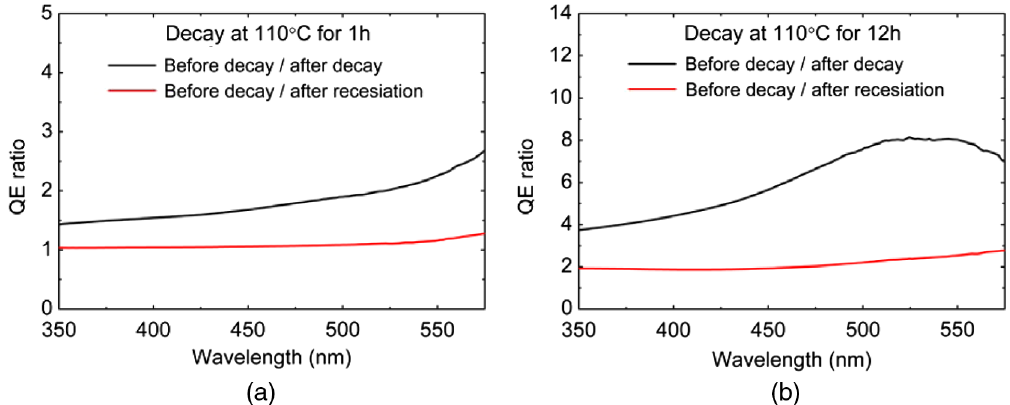
FIG. 7. Ratio of the QE before decay to the QE after decay and the ratio of the QE before the decay to after recesiation on photocathodes decayed at 110 °C for 1 hour (a) and 12 hours